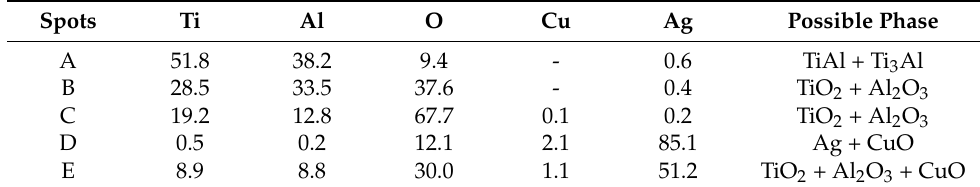
Table 4. EDS result of each spot in Figure 6 (at. %).